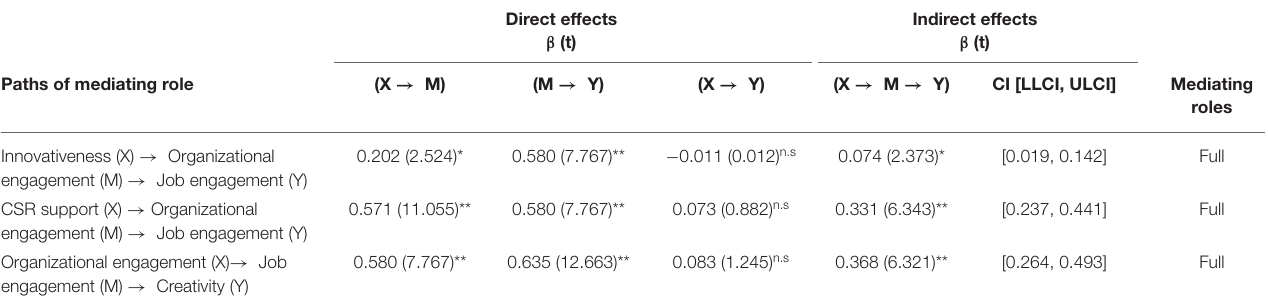
TABLE 5 | Mediating role of employee engagement using